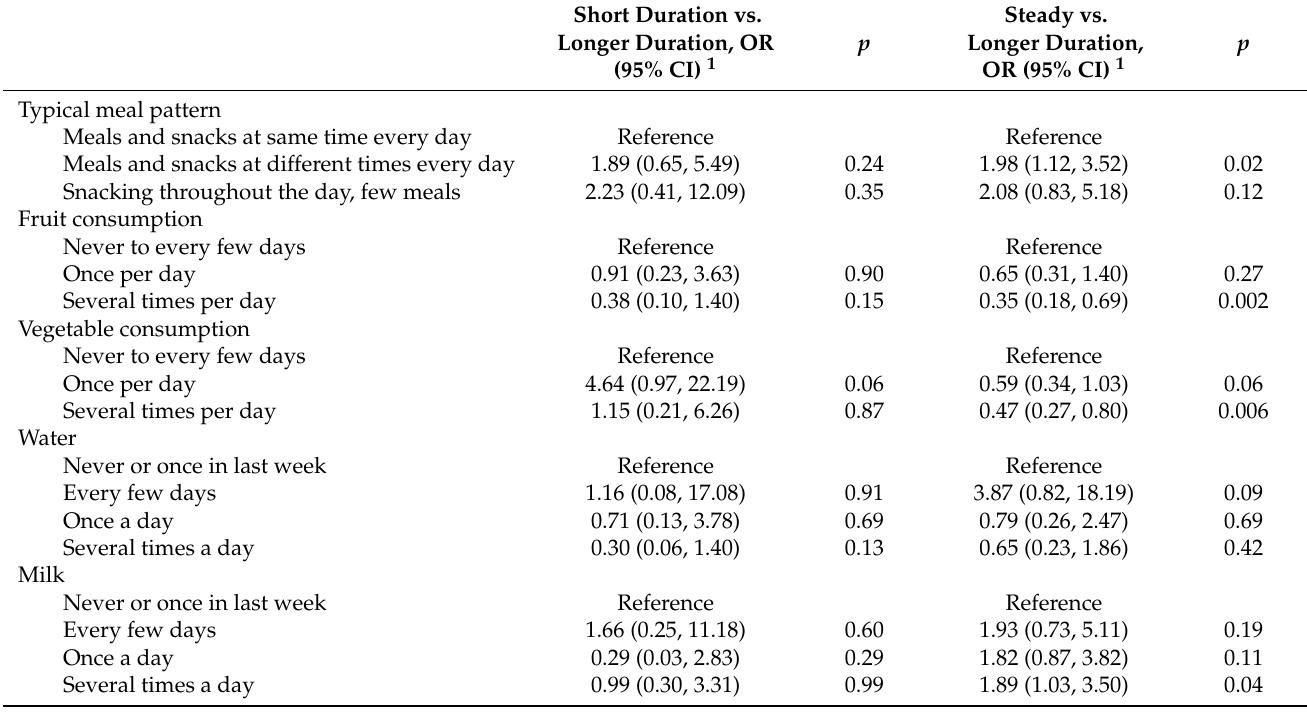
Table 3. Adjusted odd ratios of nightly children’s sleep duration trajectories according to eating behaviors at age 2; 559 children enrolled in Center for Oral Health Research in Appalachia Cohort 2 between 2012 and 2018, with sleep data followed from age 2 years to age 5.5 years. Short Duration